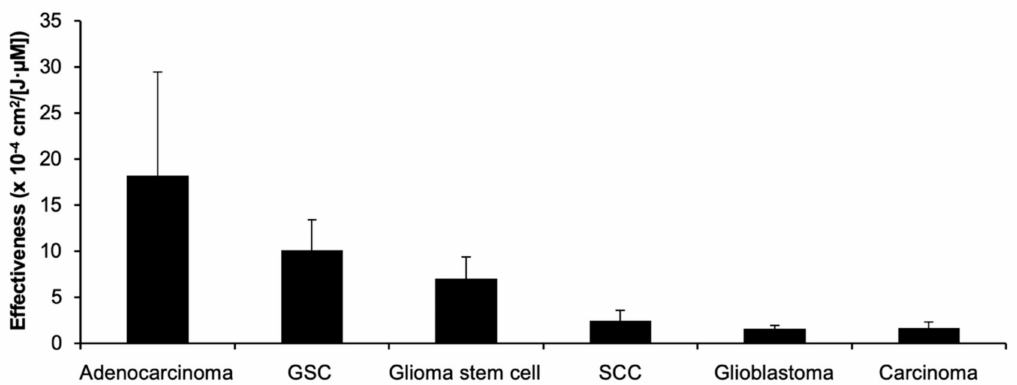
Figure 1. Effectiveness of 5-ALA PDT in cells of different cancer classifications. GSC: glioblastoma stem cell, SCC: squamous cell carcinoma. There were no statistical significances (one-way analysis of variance (ANOVA) with the post hoc Tukey– Kramer test). Adenocarcinoma ( n = 16) and glioblastoma ( n = 10) were statistically assessed using the Wilcoxon rank-sum test but showed no significant differences.